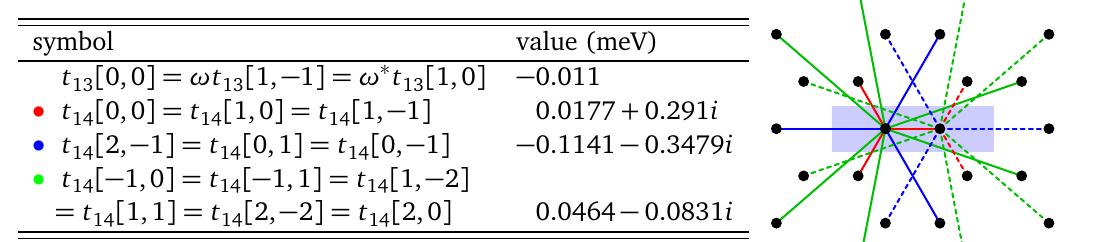
Table 1: Hopping amplitudes used in the low-energy model, the largest computed in Ref. [ 1 ] , taken from Ref. [ 24 ] and reproduced here for ease of reading. [ a , b ] stand for the bond vectors in the ( E , E basis of Fig. 1 and ω = e 2 π i / 3 . The hopping terms 1 2 ) t (full lines) and t (dashed lines) for a given layer are illustrated on the right; 14 23 the blue area is the unit